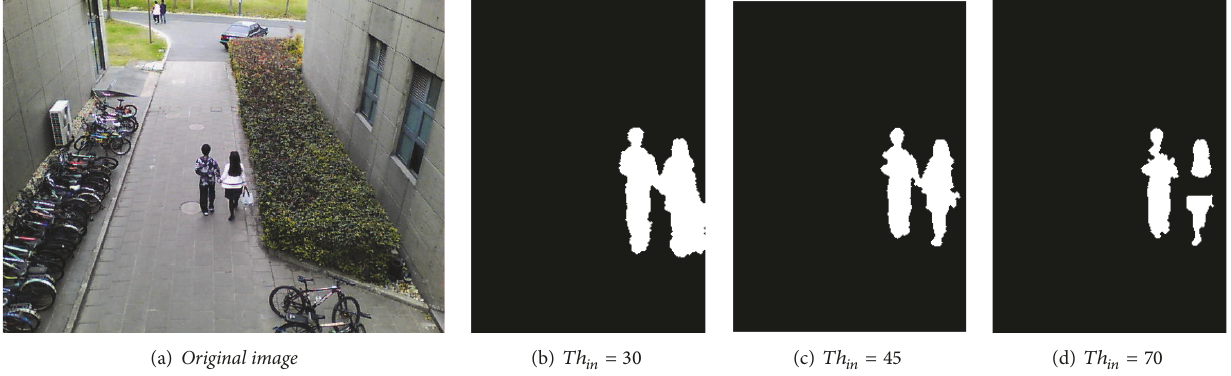
Figure 8: The results of motion foreground extraction with different threshold 𝑇ℎ V 𝑖 . Table 3: Infrared detection results in a nighttime scenario.